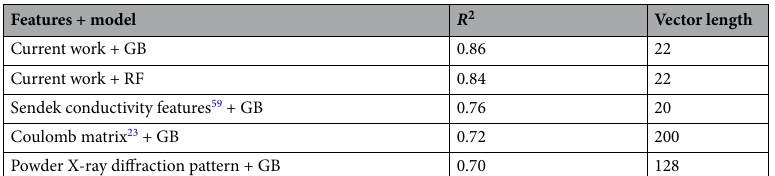
Table 3. The cross-validated performance of our RF and GB models trained using 22 input features on the 3D barrier prediction task. Also compared are three other structure-based representations from literature (with the same GB model in each case).